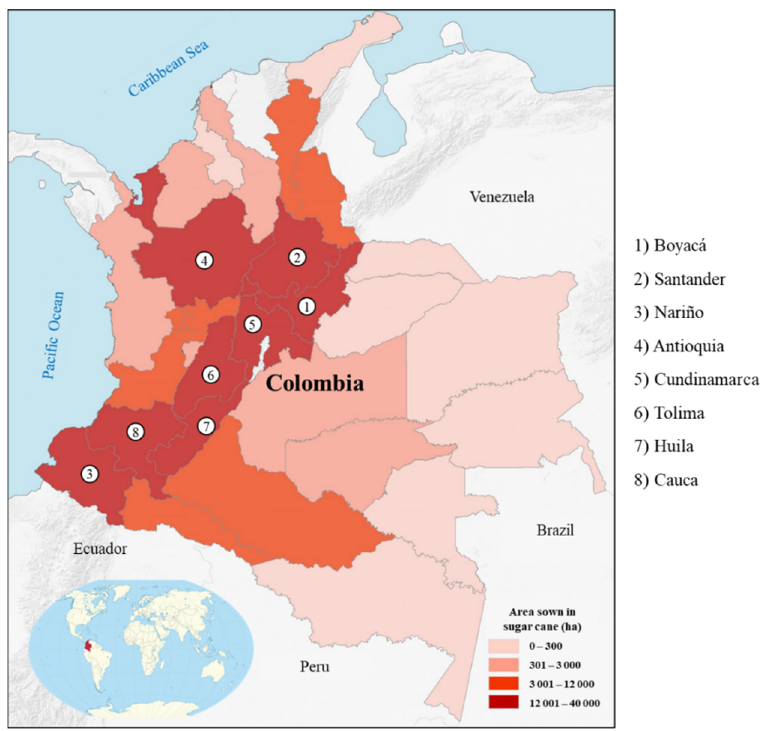
Figure 2. Map of the study area: sugarcane plantations in Colombia used to produce NCS; adapted from AGRONET [32].